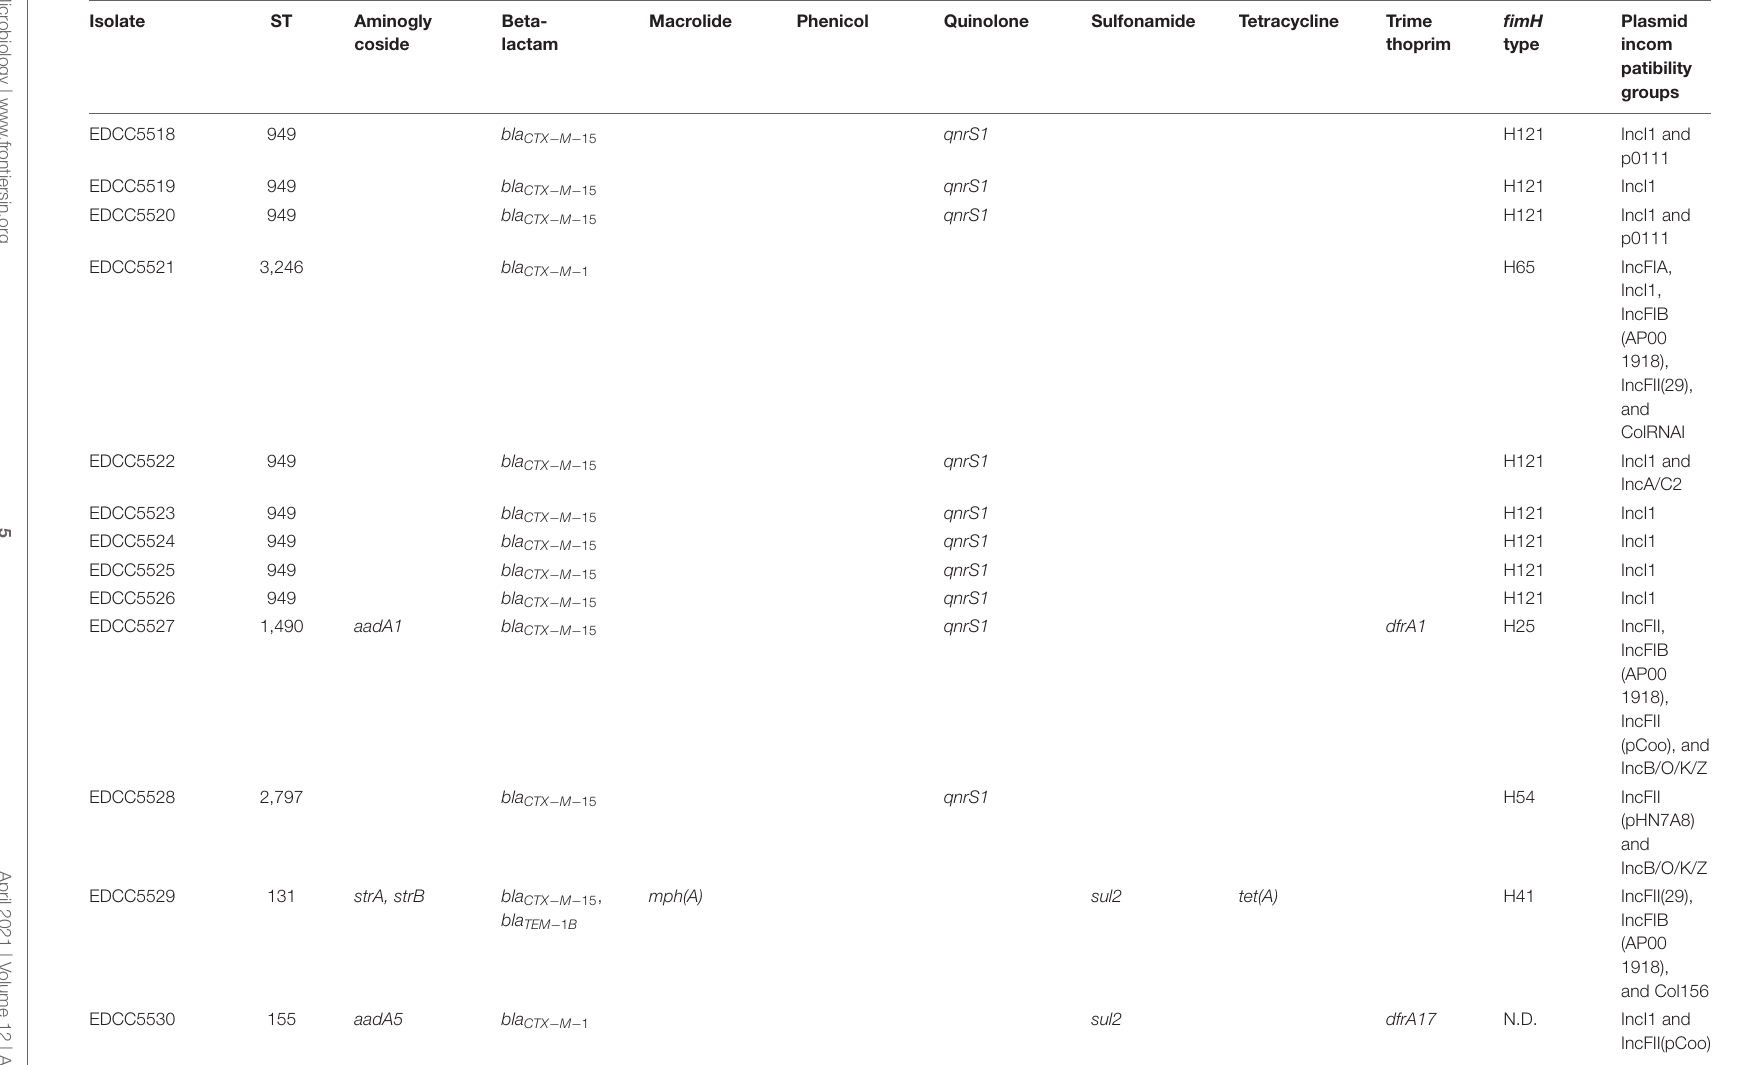
TABLE 2 | Results of the genome-based analysis of the ESBL-producing E. coli isolates.